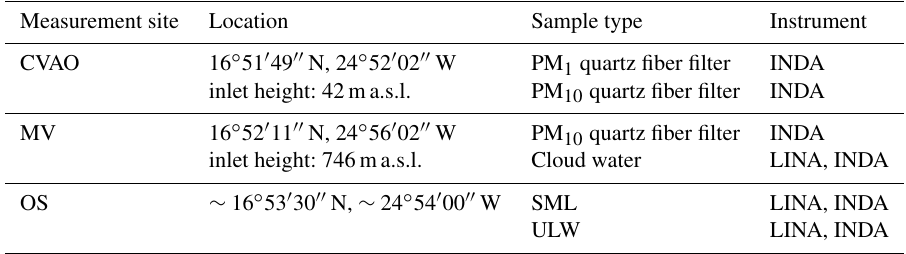
Table 1. Measurement sites, locations, sample types and measurement